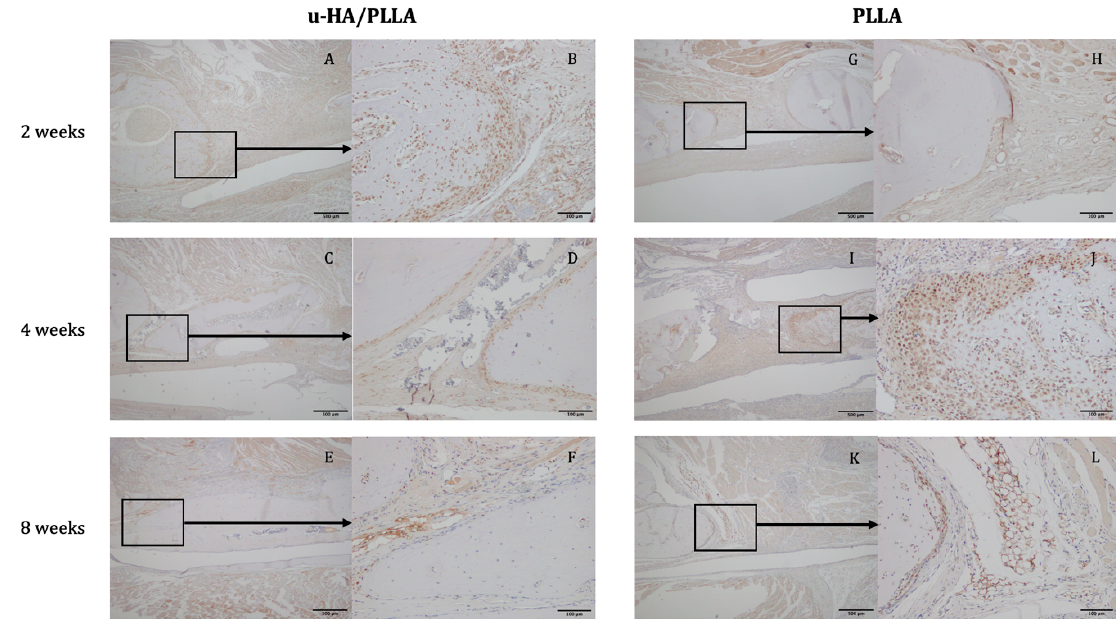
Figure 6. Expression of Runx2 in the u-HA / PLLA and PLLA groups. ( A – F ): In the u-HA / PLLA group, Runx2 expression decreased significantly from weeks 2 to 8. ( G – L ): Runx2 expression in the PLLA group was generally lower, except in specimens with new bone. ( A , C , E ): Images of the u-HA / PLLA-treated samples taken at 4 × magnification at weeks 2, 4, and 8, respectively. ( G , I , K ): Images of PLLA-treated samples taken at 4 × magnification at weeks 2, 4, and 8, respectively. ( B , D , F , H , J , L ): Images of the boxed regions in ( A , C , E , G , I , K ), respectively, at 20 × magnification.